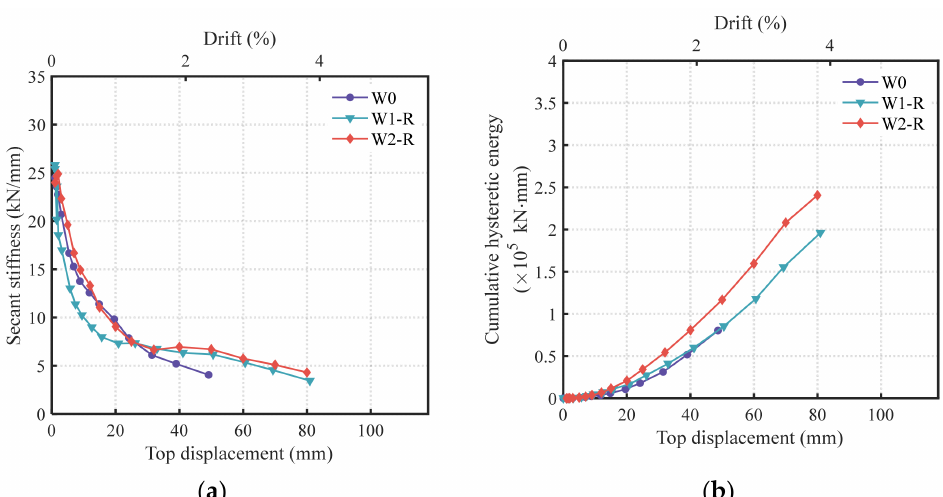
Figure 22. Comparison of stiffness degradation and cumulative energy dissipation. ( a ) Stiffness degradation; ( b ) Cumulative hysteretic